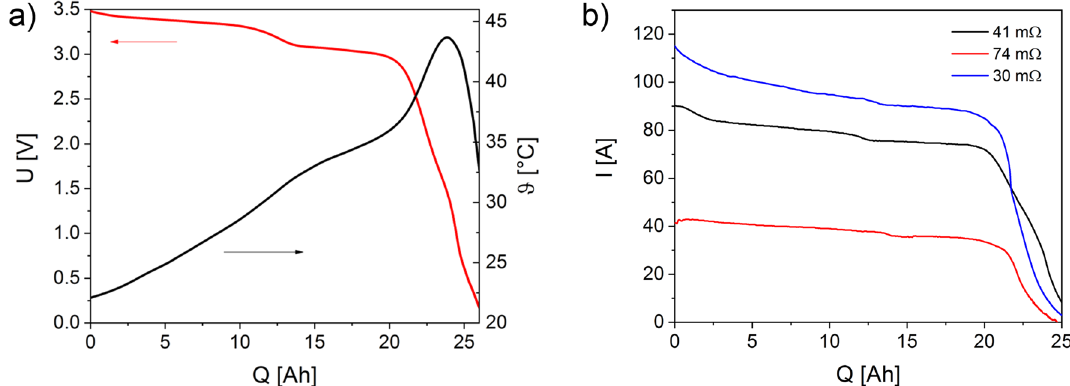
Figure 1. ( a ) Voltage and temperature behavior during a deep discharge of a single cell at 41 mΩ; ( b ) current behavior at different